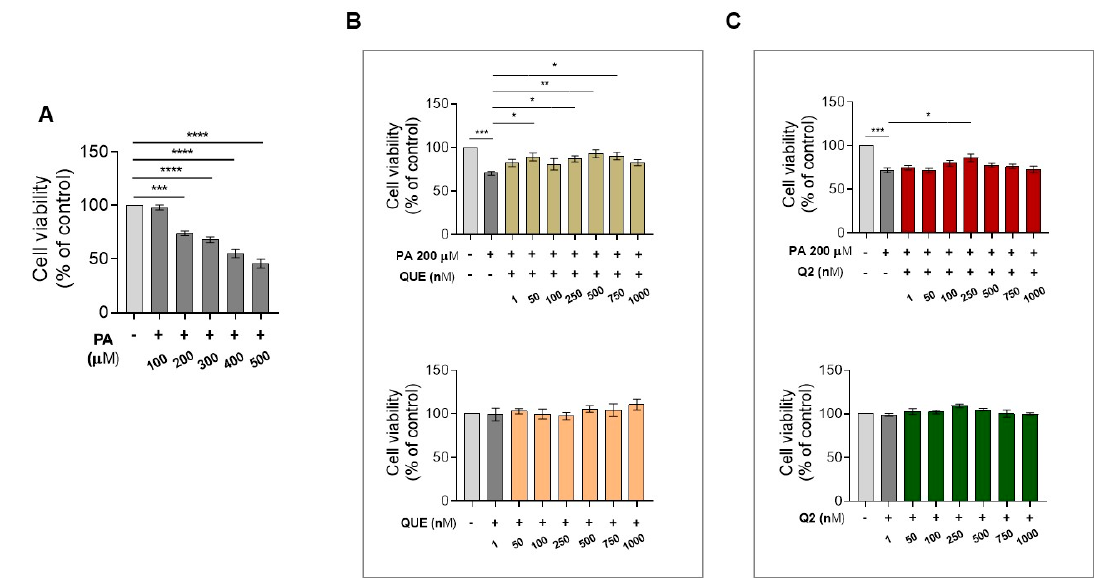
Figure 1. Effects of PA with or without QUE and Q2 on cell viability in H9c2 cardiomyocytes. H9c2 cardiomyocytes treated with vehicle (control) or increasing concentrations of ( A ) PA (100–500 µM) for 24 h; ( B ) QUE (1–1000 nM) for 2 h and PA 200 µM for 24 h or QUE alone (1–1000 nM) for 24 h; or ( C ) Q2 (1–1000 nM) for 2 h and PA 200 µM for 24 h or Q2 alone (1–1000 nM) for 24 h. Cell viability was determined by MTT assay and expressed as a percentage of control cells exposed to vehicle alone (indicated as Control). Results are represented as mean ± SEM ( n = 6 per group). Significant differences (* p < 0.05, ** p < 0.01, *** p < 0.001, **** p < 0.0001) were detected by a one-way ANOVA, followed by Dunnett’s test vs. the control group and Newman–Keuls multiple comparison test vs . control group and vs. PA group.